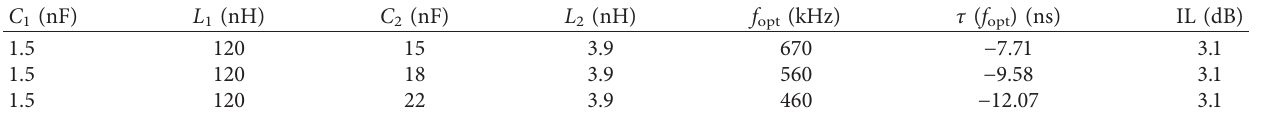
Table 7: Element values of the high-pass negative group delay circuit with different C